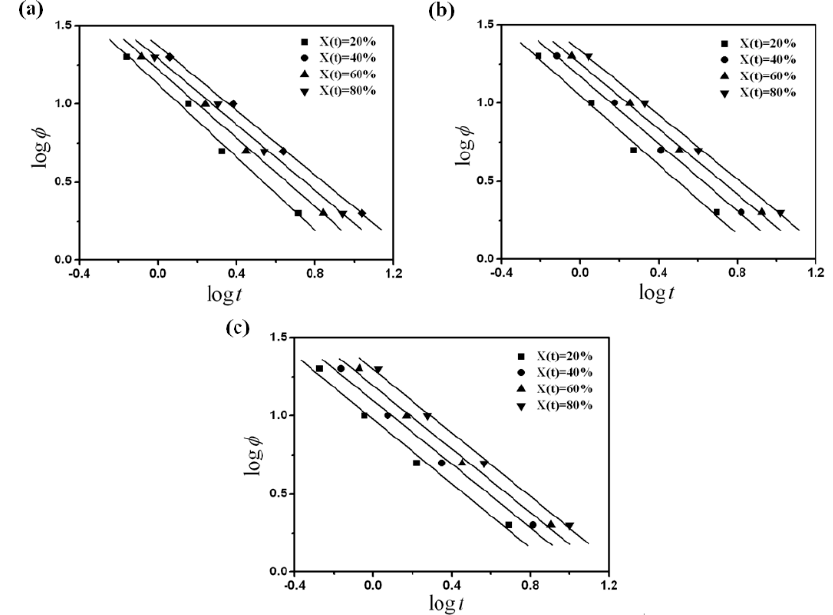
Figure 5. Plots of log φ versus log t from Mo’s analysis for ( a ) PVDF / DMP, ( b ) PVDF / DEP and ( c ) PVDF / DBP. Table 4. Values of b and F ( t ) at various values of X ( t ) for PVDF / dialkyl phthalate blends.